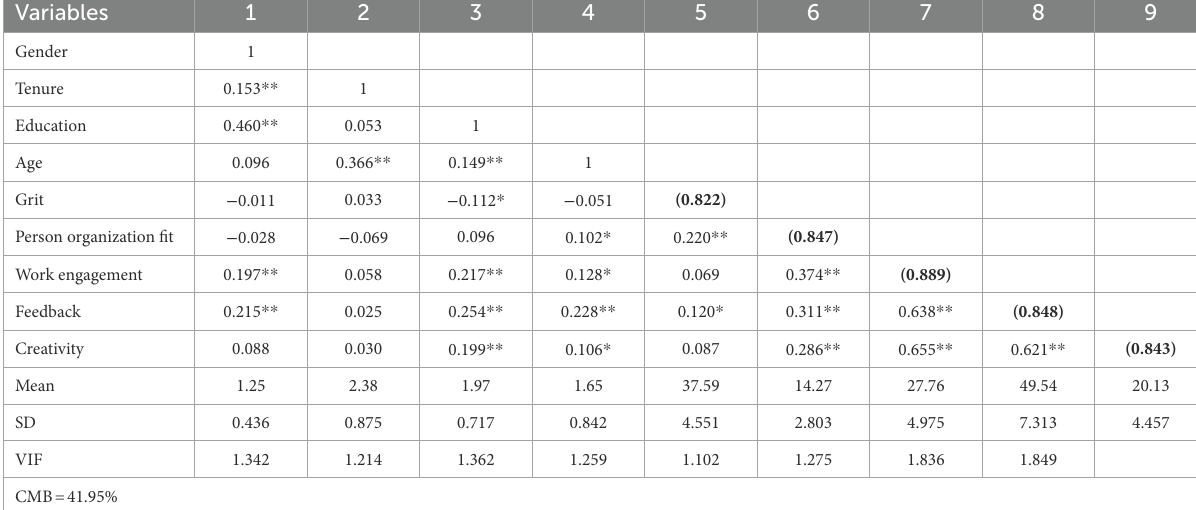
TABLE 2 Descriptive statistics, mean, standard deviation, and